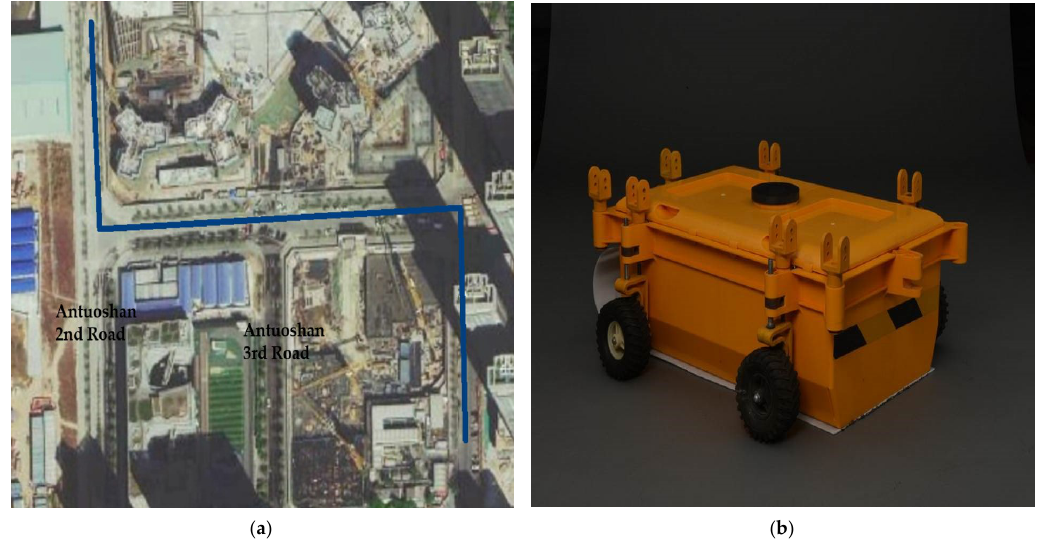
Figure 3. Detection route and equipment: ( a ) Detection route marked by blue line; ( b ) Detection equipment.